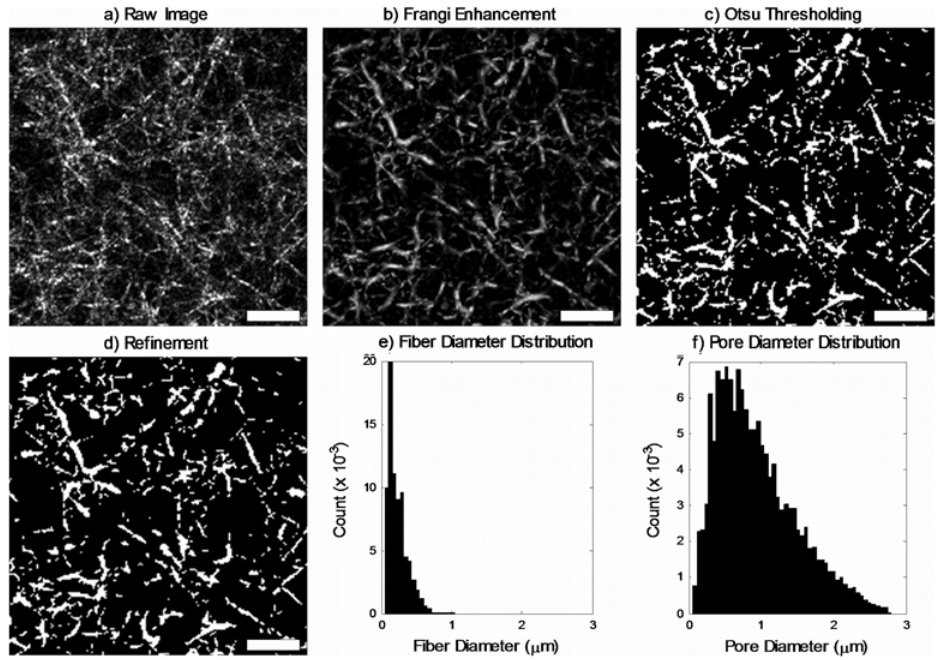
Fig 3. Implementation of fiber analysis. Sample shown is a 1024x1024 pixel subimage of a 4 mg/ml hydrogel polymerized at pH 7.4 and 37°C. Scale bar 10 μ m.